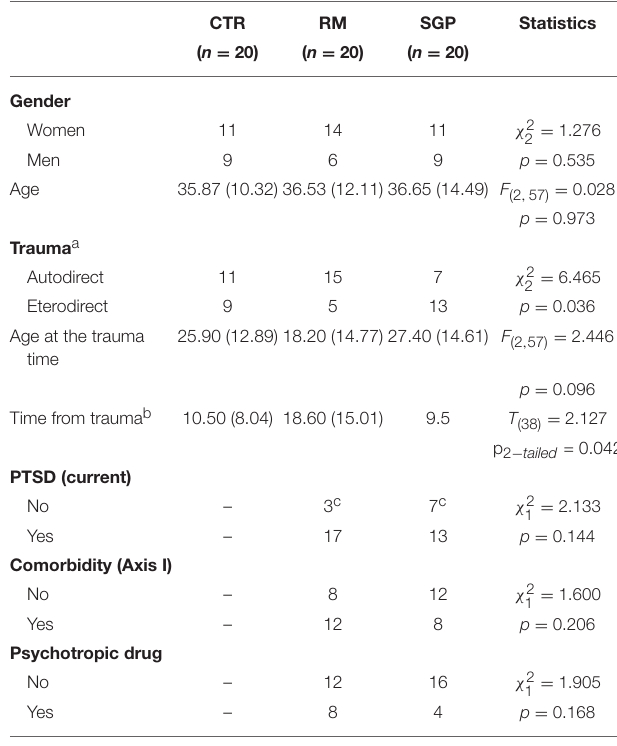
TABLE 1 | Socio-demographic and clinical descriptive